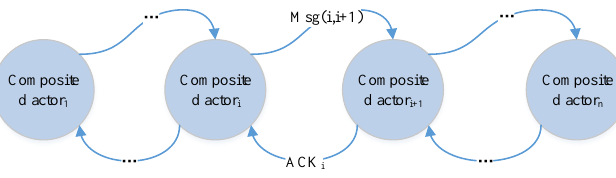
Figure 17. One-order feedback dynamic processing.